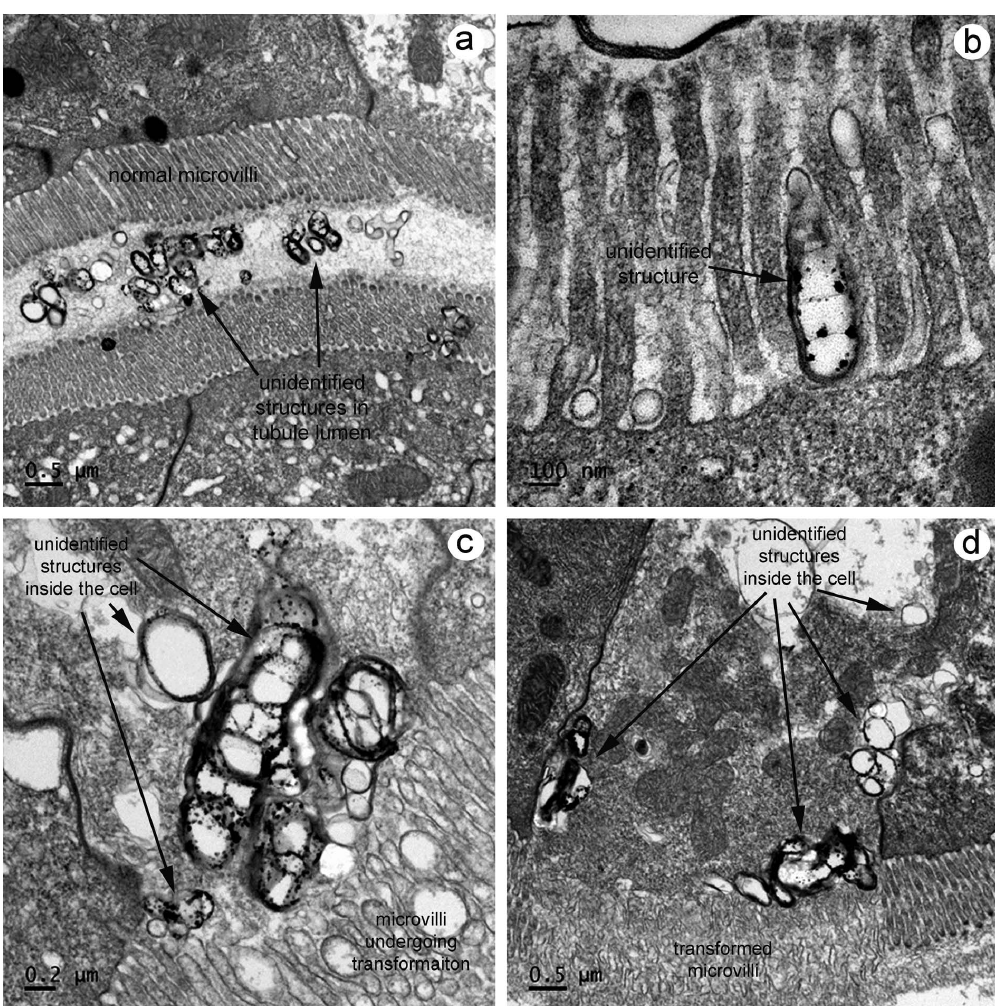
Figure 8. TEM of unusual electron-dense particles in HP tubule crypts. (a) Low magnification of electron-dense particles of highly variable shape in the HP tubule lumen between layers of normal microvilli from facing epithelial cells. (b) High magnification of one of the electron-dense particles between the microvilli on the outside surface of an epithelial cell, possibly prior to cell entry. (c) High magnification of electron dense particles inside an epithelial cell with adjacent microvilli on the cell surface undergoing morphological changes. (d) Low magnification of an epithelial cell containing large numbers of electron dense particles and with microvilli in an advanced stage of transformation.